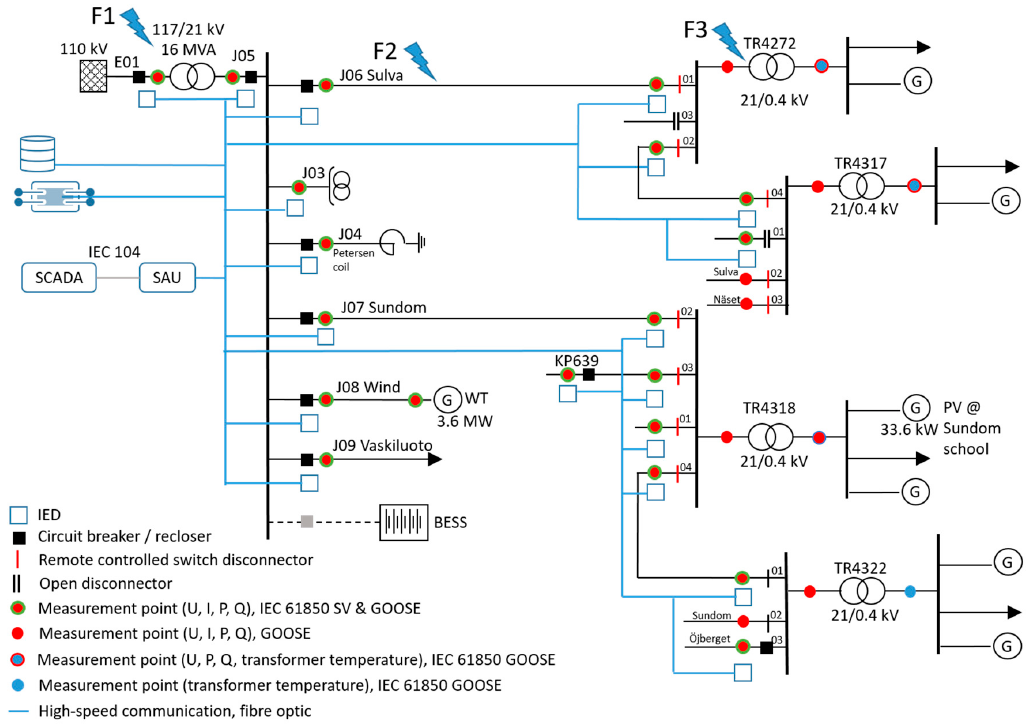
Figure 8. Single line diagram of the Sundom Smart Grid. Adapted from [49].